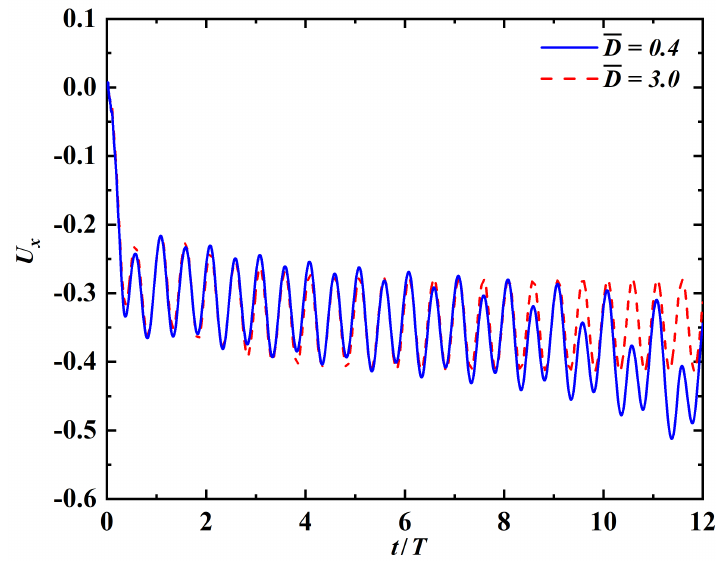
Figure 13. Time histories of the leading-edge’s horizontal velocity at ¯ D = 0.4 and ¯ D = 3.0. From the time history of horizontal velocity at the leading edge for ¯ D = 0.4, both f and 2 f are identified as the dominant frequencies. This is in contrast with the case of ¯ D = 3.0, in which only 2 f is identified as the dominant frequency. This phenomenon is related to the fact that the ground effect breaks the spatial-temporal symmetry of the flow field. The instantaneous vorticity contours for the case of ¯ D = 0.4 is shown in Figure 14. It is clearly seen that a reverse Karman vortex street with upward deflection is